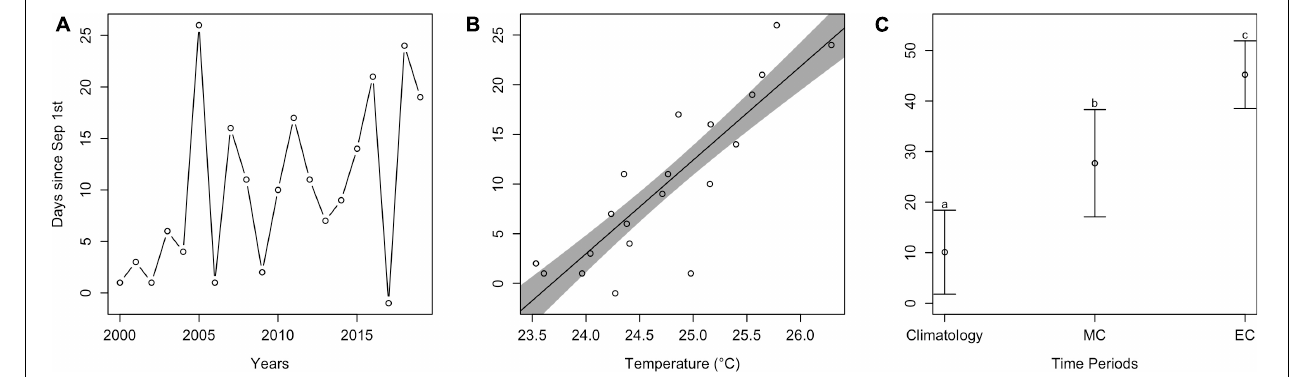
FIGURE 5 | Estimated departure plots. (A) Estimated departure time of cobia each year from 2000 to 2019. (B) The dots represent estimated cobia departure times over mean September temperatures in Chesapeake Bay, while the line and shaded region represent model output and uncertainty. (C) Mean estimated cobia departure time among climatology (i.e., contemporary), mid-century (MC), and end-of-century (EC) time periods. Different lower case letters indicate a statistical difference between time periods.